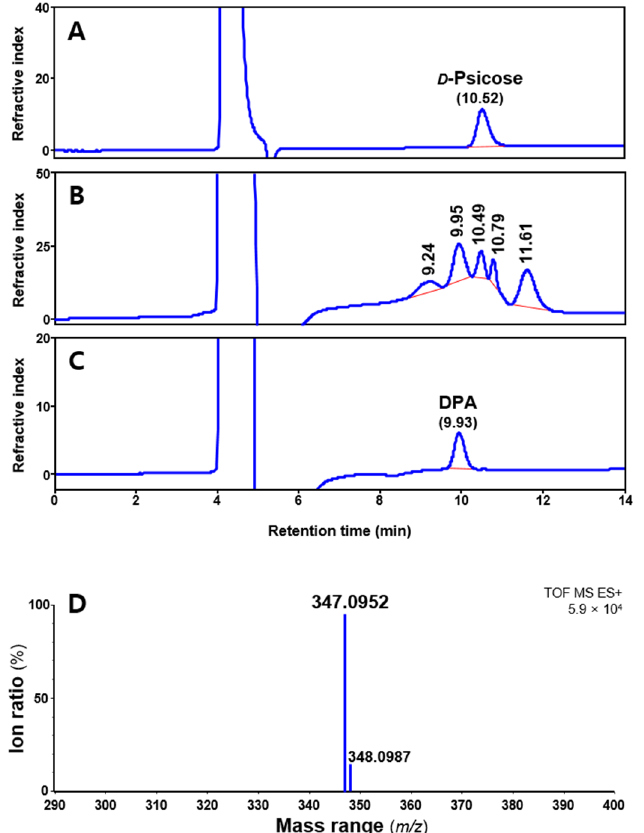
Figure 1. High-performance liquid chromatography chromatograms of D -psicose standard ( A ), acidify reactant ( B ), isolated single compound ( C ), and high-resolution mass spectrometry spectrum of di- D -psicose anhydride (DPA) ( D ).